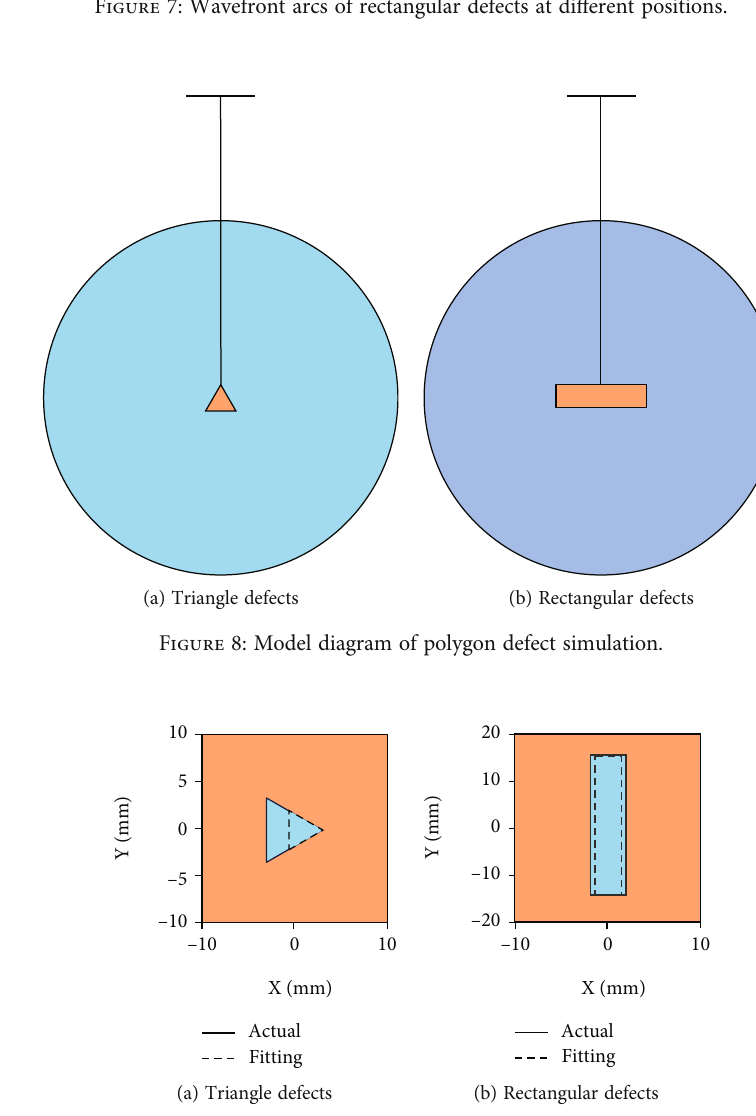
Figure 9: The result diagram of polygon defect